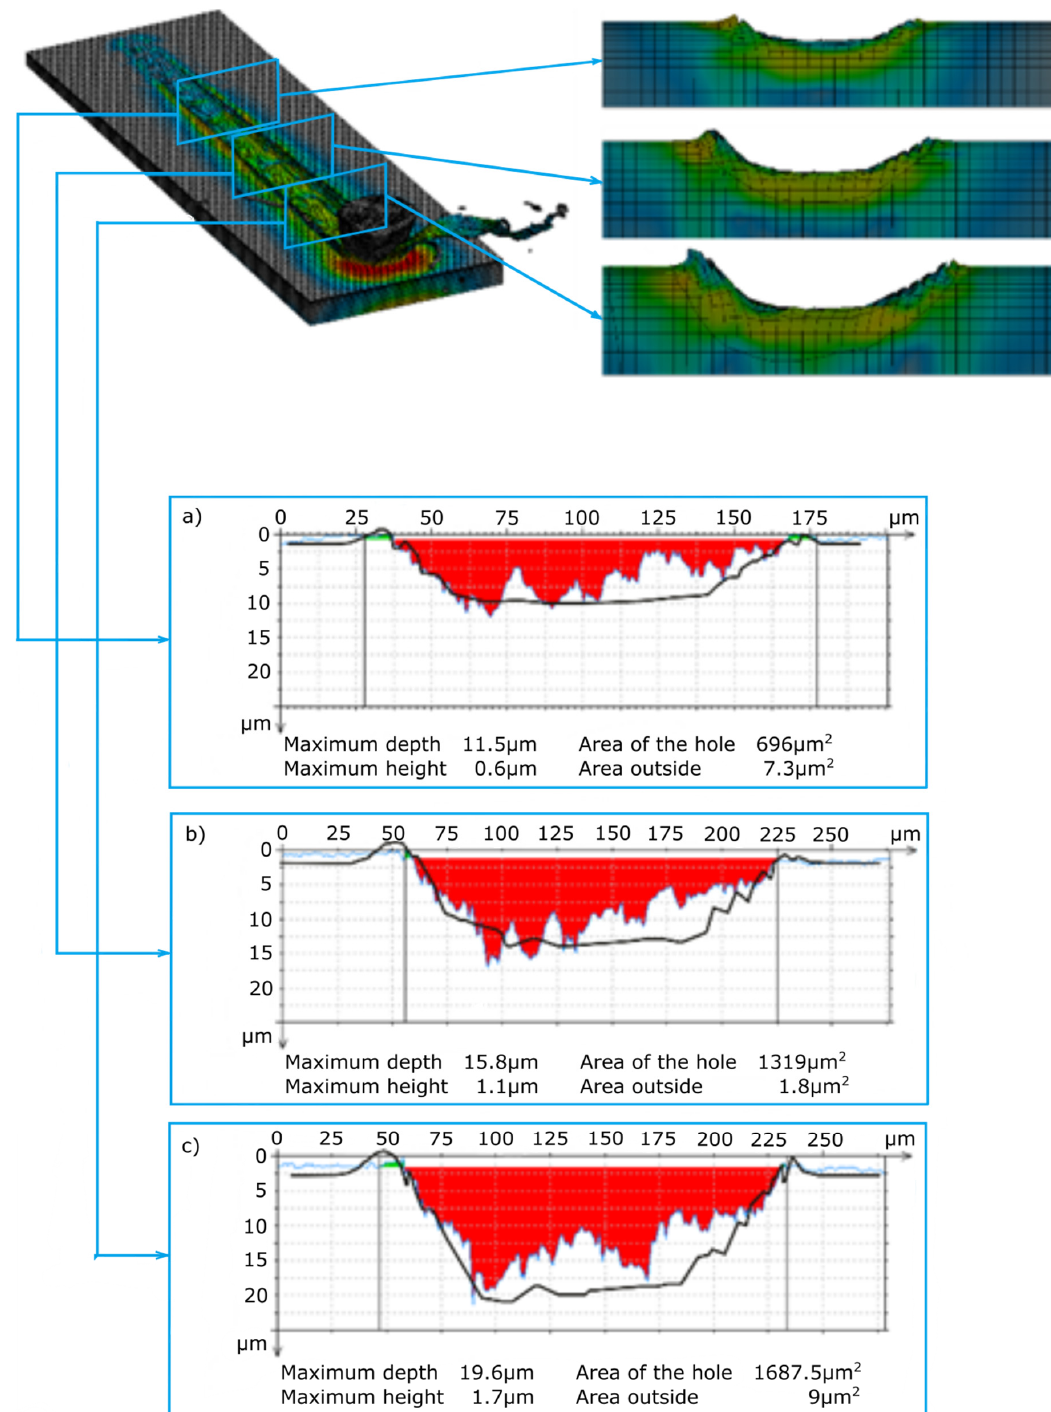
Figure 10. Results of the profiles of the scratch formed in the process of microcutting with the ZS1 grain (simulation tests); ( a ) validation of the scratch profiles in the simulation tests for a depth of cut of 10 µm, ( b ) validation of the scratch profiles in the simulation tests for a depth of cut of 15 µm, and ( c ) validation of the scratch profiles in the simulation tests for a depth of cut of 20 µm.